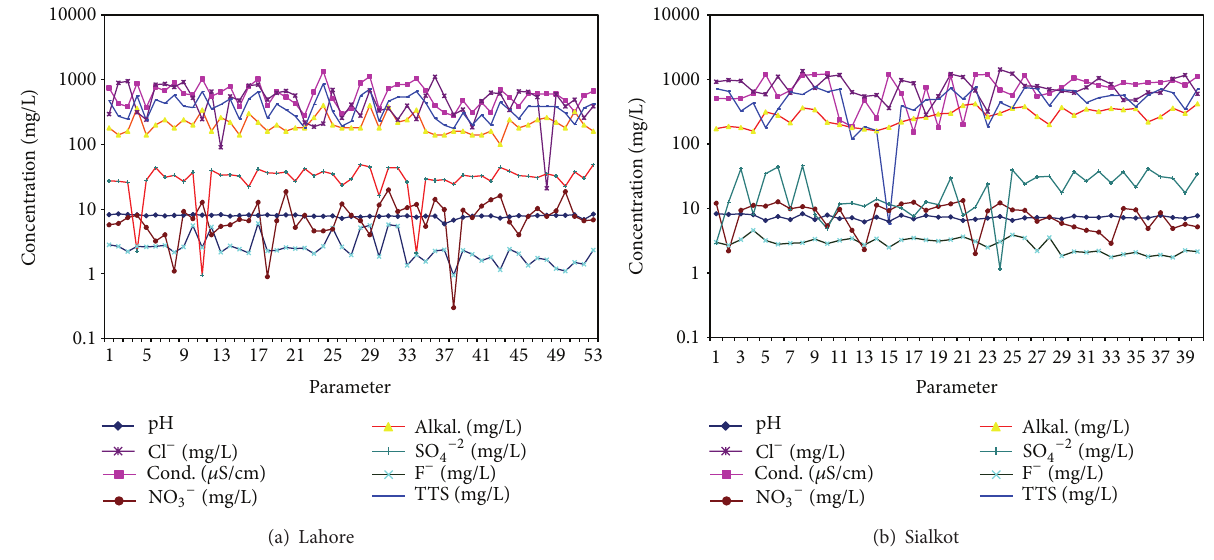
Figure 2: Distribution of different parameters in drinking water samples from Lahore and Sialkot. Table 1: Basic statistics for the physicochemical parameters of drinking water samples from Lahore and